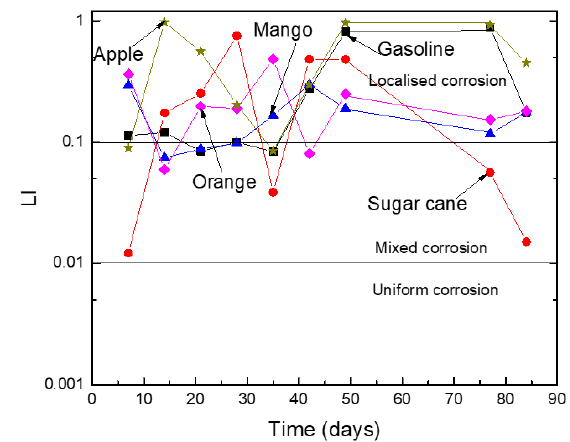
Figure 6. Variation on the LI value for Al in the different ethanol–gasoline blends.